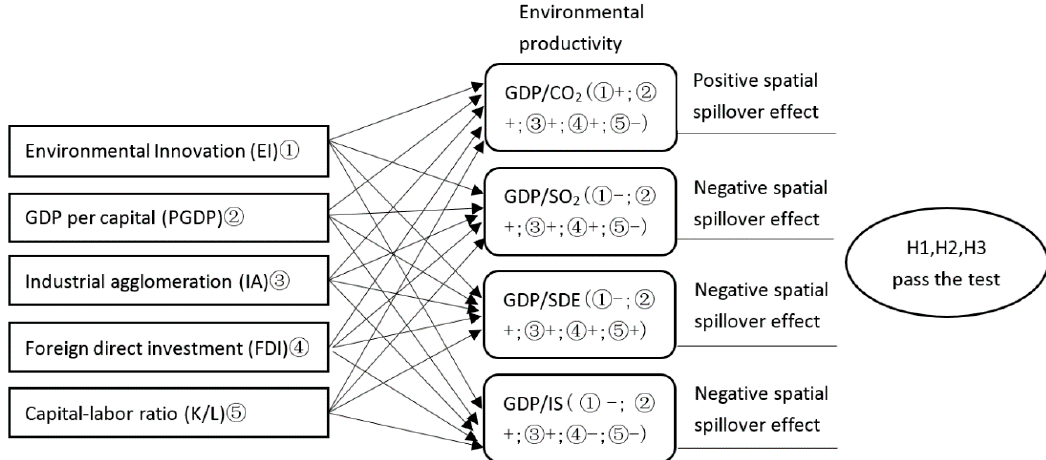
Figure 2. Research results (+, positive; − , negative).